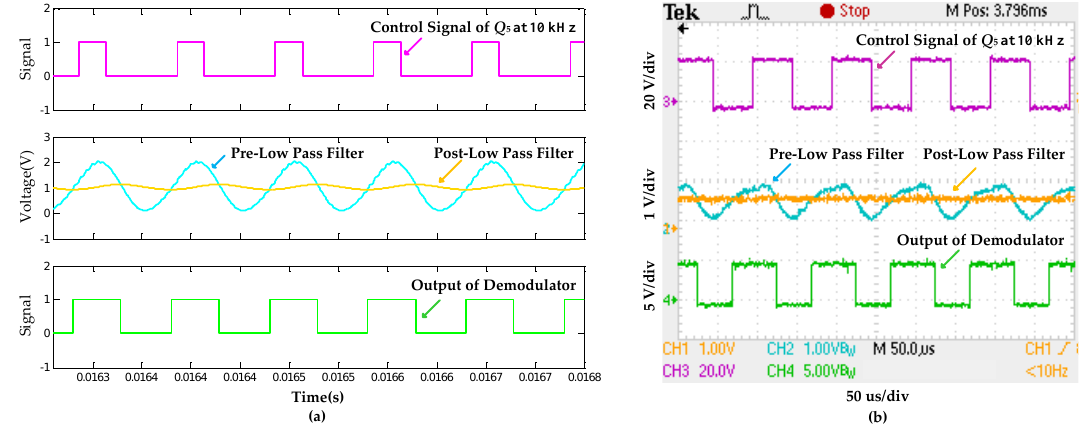
Figure 16. The backward transmission waveform of Q5 frequency at 10 kHz ( a ) simulation result ( b ) experimental result.